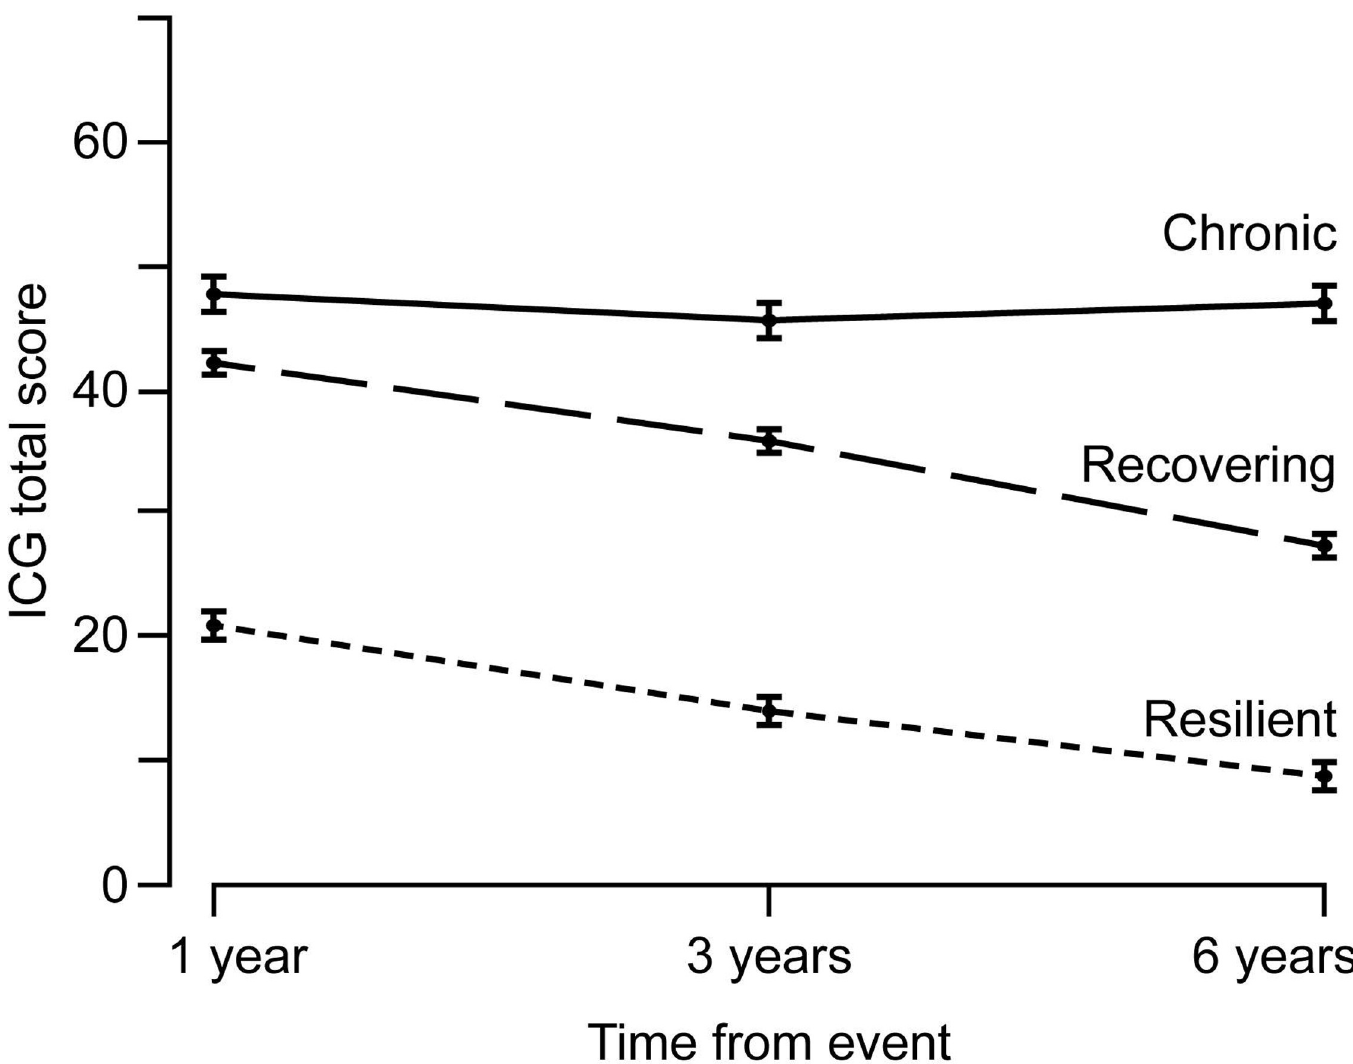
Fig 1. Trajectories of grief among bereaved disaster survivors. Note: ICG, Inventory of Complicated Grief. Error bars indicate standard errors.